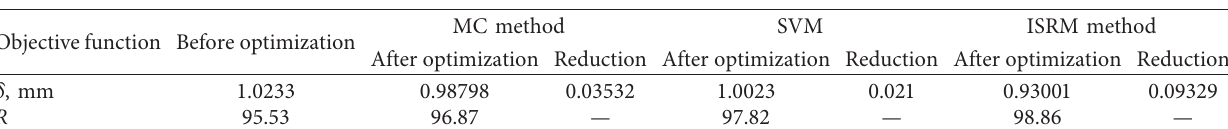
Table 5: Optimization results of turbine blade deformation with different